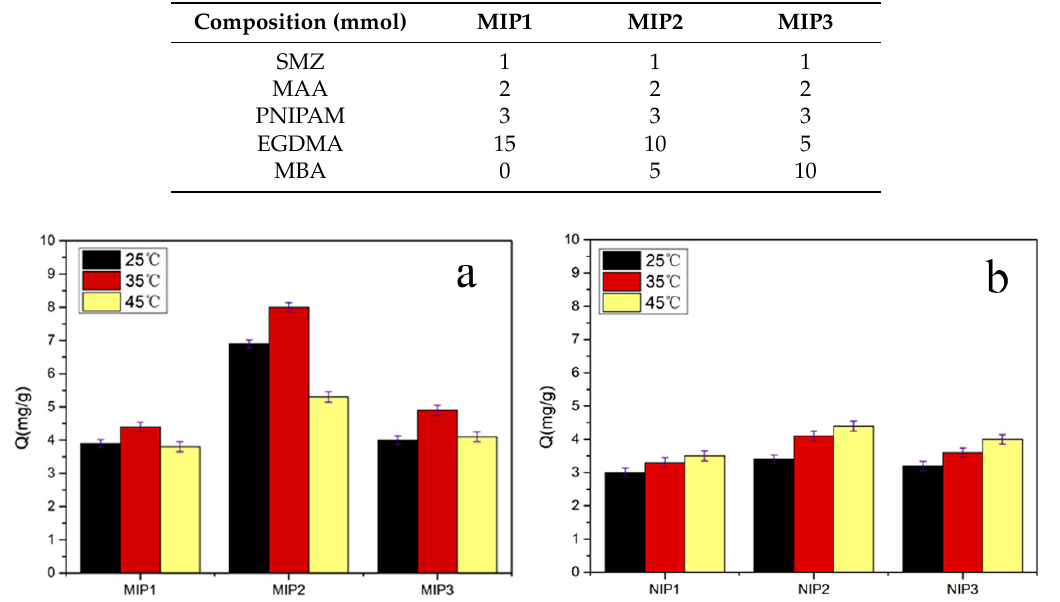
Table 1 . Synthetic formula of MIPs. Table 1. Synthetic formula of MIPs.